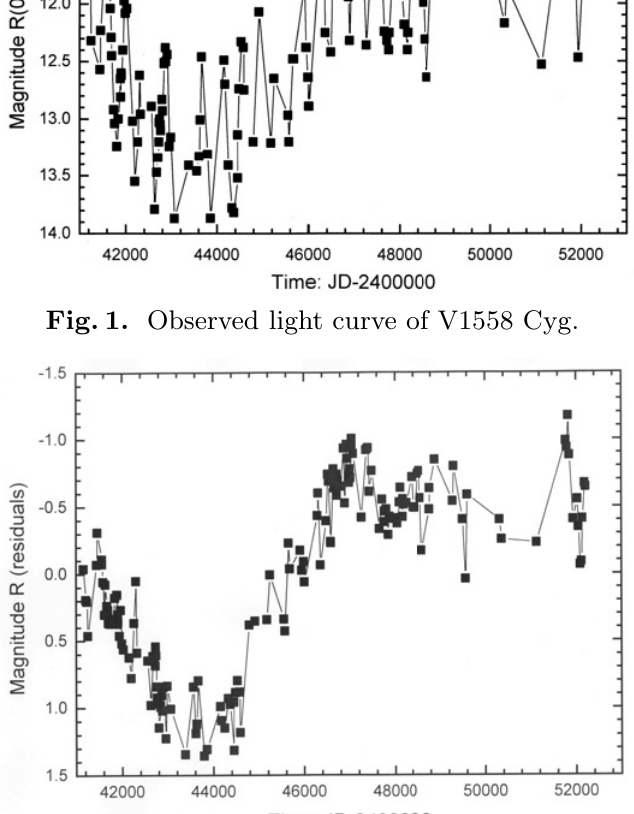
Fig. 2. Pre-whitened light curve of V1558